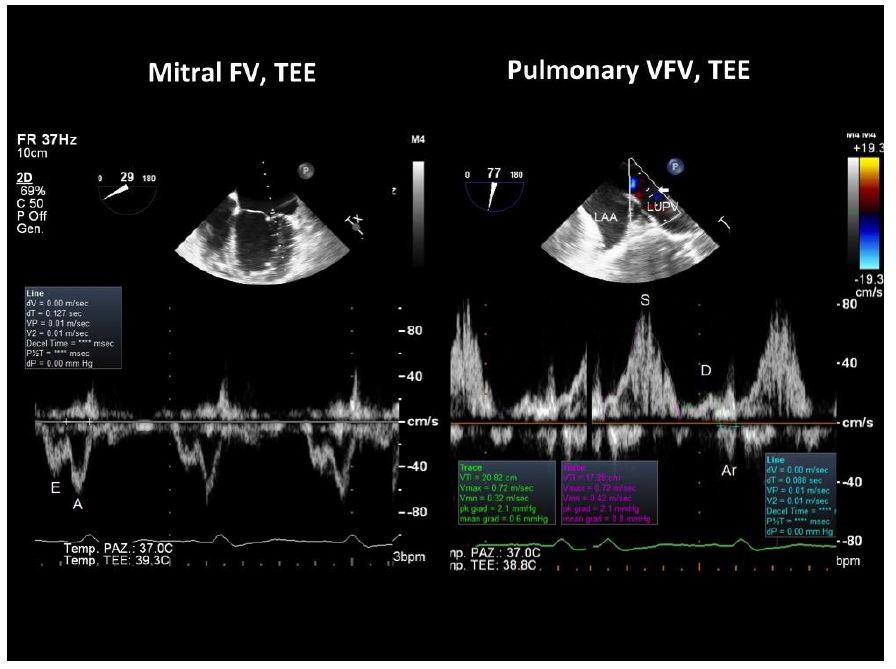
Figure 3. TEE recording of the mitral and pulmonary venous flow velocity in a patient with DCM showing a fairly normal peak VO 2 (21 mL/kg/min). On the left, mitral flow velocity is displayed (bottom), and at the top, there is a 2D image showing the location of the sample volume in the LV (at the mitral annulus); the E/A ratio of the mitral waves was 0.7. On the right, the pulmonary venous flow is shown (bottom), and at the top, there is a 2D image showing the sample volume location 1 cm beyond the orifice of the left upper pulmonary vein with the left atrium, as indicated by the arrow: the systolic fraction of the venous flow was normal (82%); Arv-A was also normal ( − 39 ms), indicating a delayed relaxation of the LV with no increase in the filling pressure. TEE = transesophageal Doppler echocardiography; FV = flow velocity; VFV = venous flow velocity.